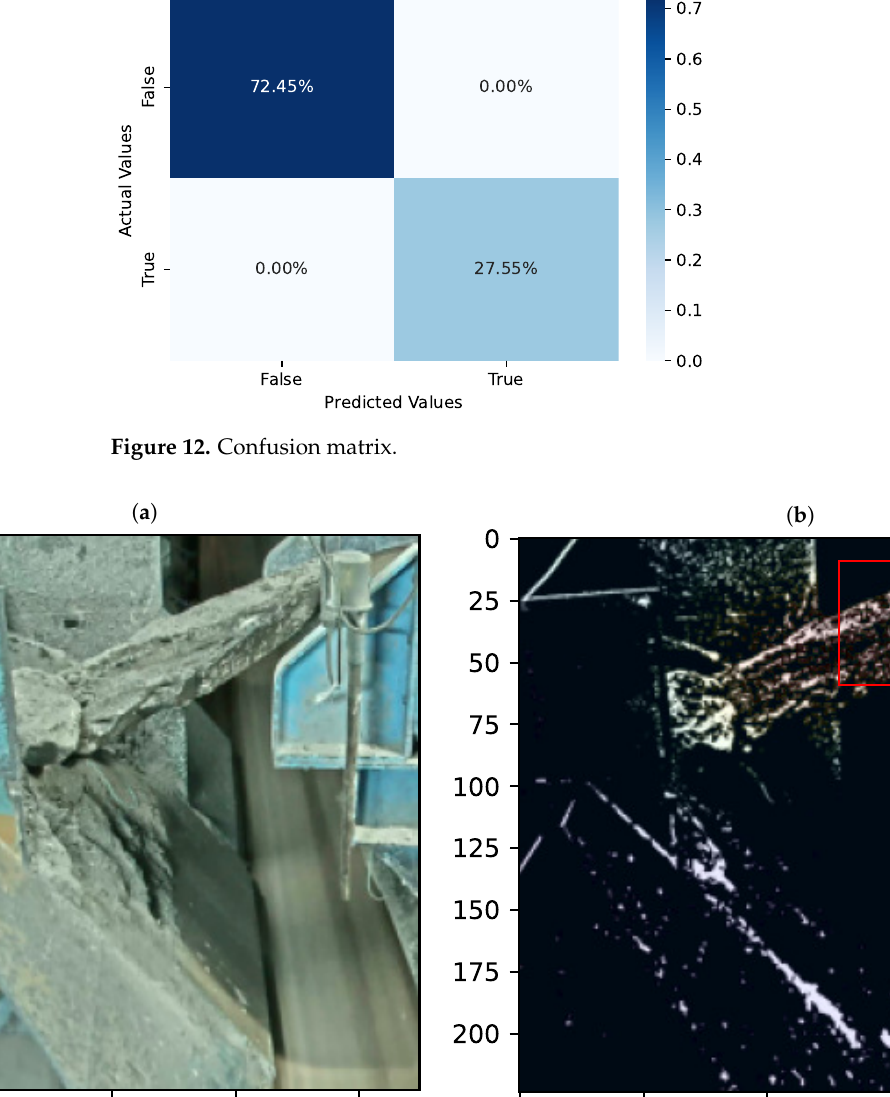
field with a red border indicates only the area of the detected most significant number of outlier pixels.